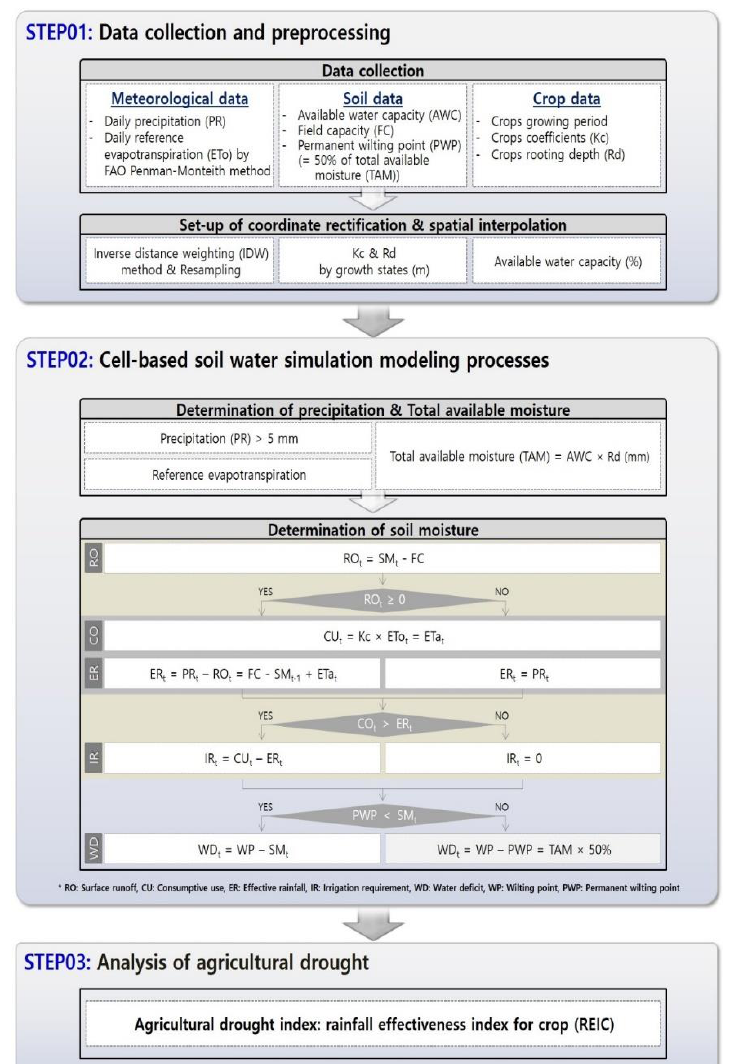
Figure 1. Procedure for cell-based daily soil water analysis modeling.